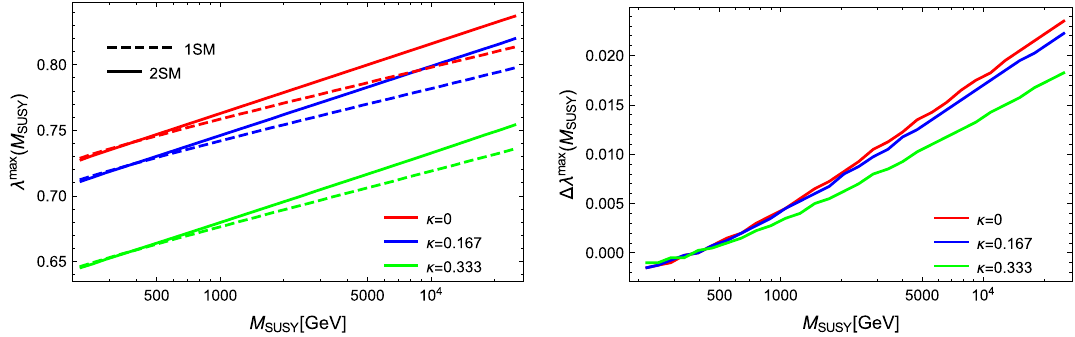
Fig. 13 Left maximal value of λ( M SUSY consistent with perturbativity up to M GUT for different values of κ . The full ( dashed ) lines correspond to the case of two- (one-) scale matching. Right the difference (cid:9)λ = λ max